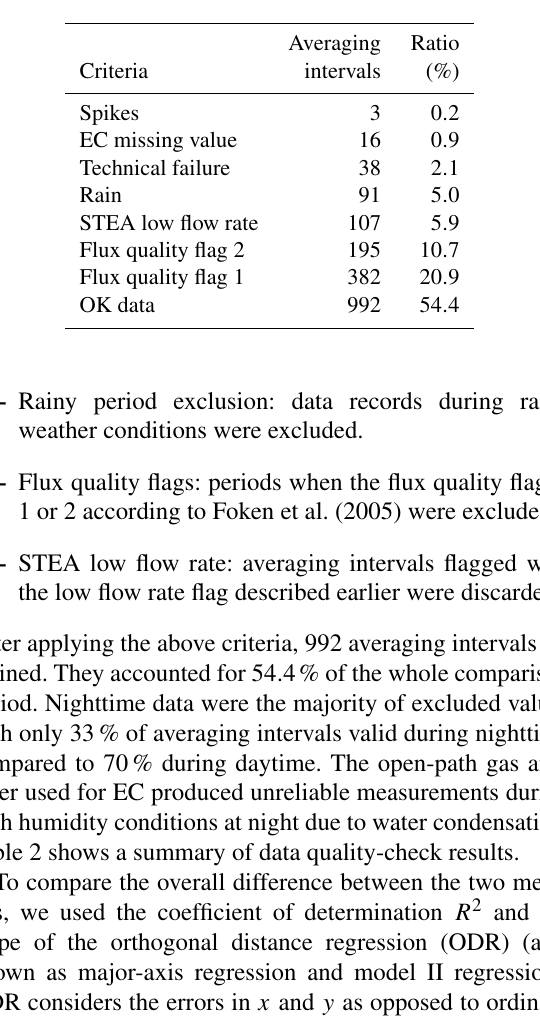
Table 2. Summary of data quality checks for STEA and EC fluxes used in the EC–STEA flux intercomparison showing the number of averaging intervals that were excluded and the ratio of the excluded averaging intervals to the total for each criterion. Details on the cri- teria and the thresholds used are provided in Sect.